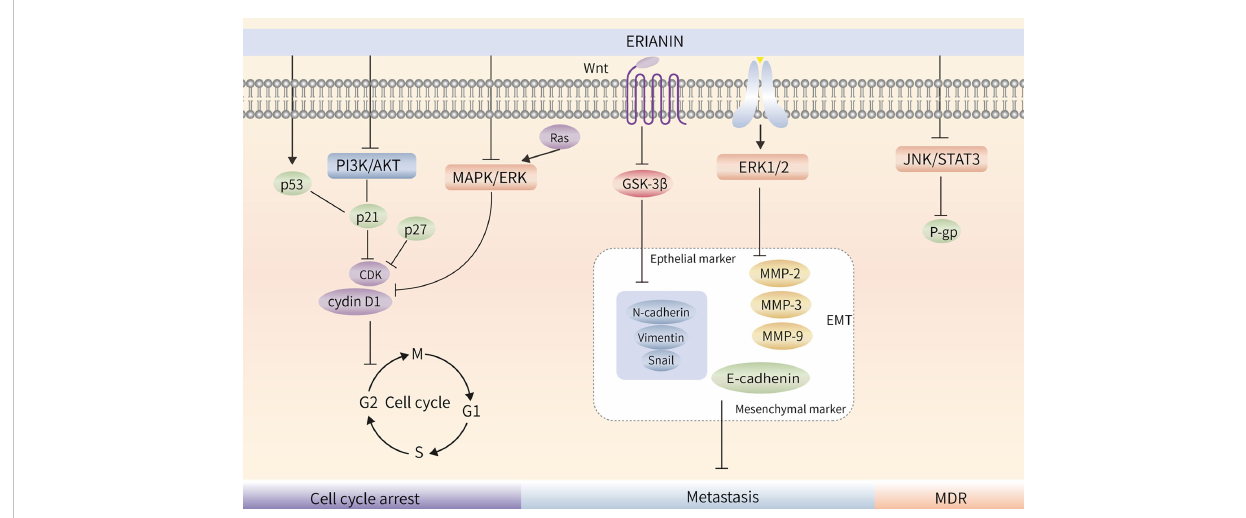
FIGURE 3 ERIANIN regulates cell cycle, metastasis and MDR. ERIANIN regulates cell cycle through the PI3K/AKT and MAPK/ERK pathway. ERIANIN regulates the EMT process through the GSK3 b and ERK1/2 pathway. ERIANIN regulates MDR through the JNK/STAT3 pathway. PI3K, phosphatidylinositol 3- kinase; AKT, serine/threonine kinase; p21, cyclin-dependent kinase inhibitor 1A; p27, cyclin-dependent kinase inhibitor 1B; CDK, Cyclin-dependent kinase; MAPK, mitogen activated kinase-like protein; ERK, Extracellular signal-regulated kinase; Wnt, wingless-type MMTV integration site family; GSK3 b , glycogen synthase kinase 3 beta; MMP2, matrix metallopeptidase 2; MMP3, matrix metallopeptidase 3; MMP9, matrix metallopeptidase 9; EMT, epithelial-mesenchymal transition; JNK, c-Jun NH2-terminal kinase; STAT3, signal transducer and activator of transcription 3; MDR, Multiple Drug Resistance; P-gp, ATP binding cassette subfamily B member